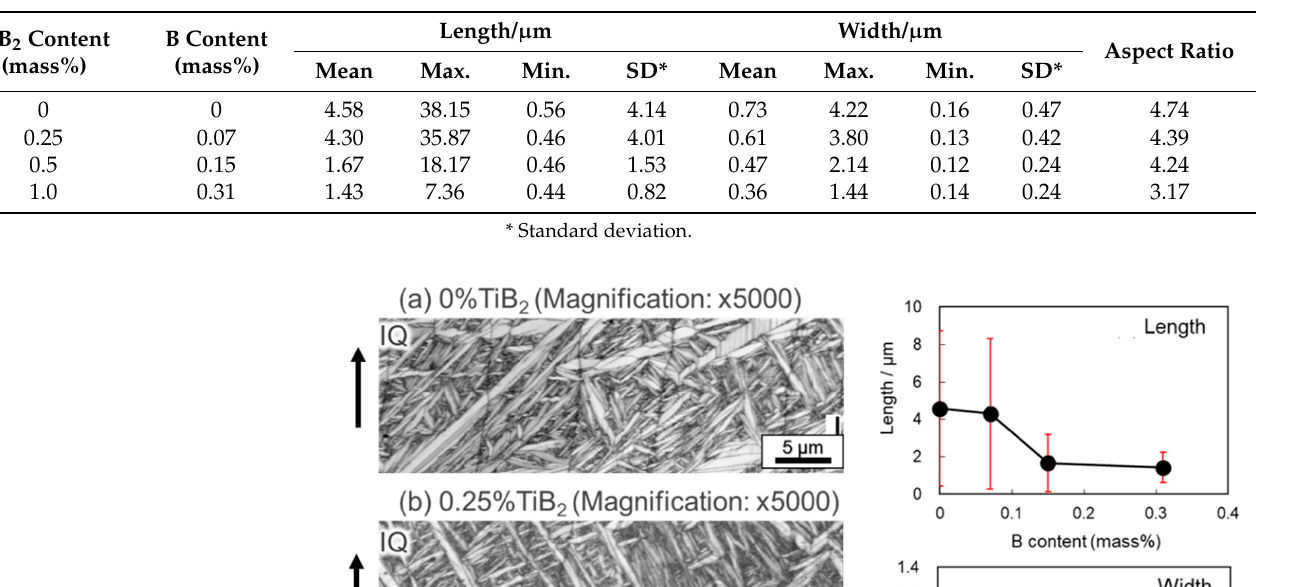
Table 3. Changes in the length, width, and aspect ratio of acicular α′ -grains in SLM Ti64 alloy composites with different TiB 2 contents.